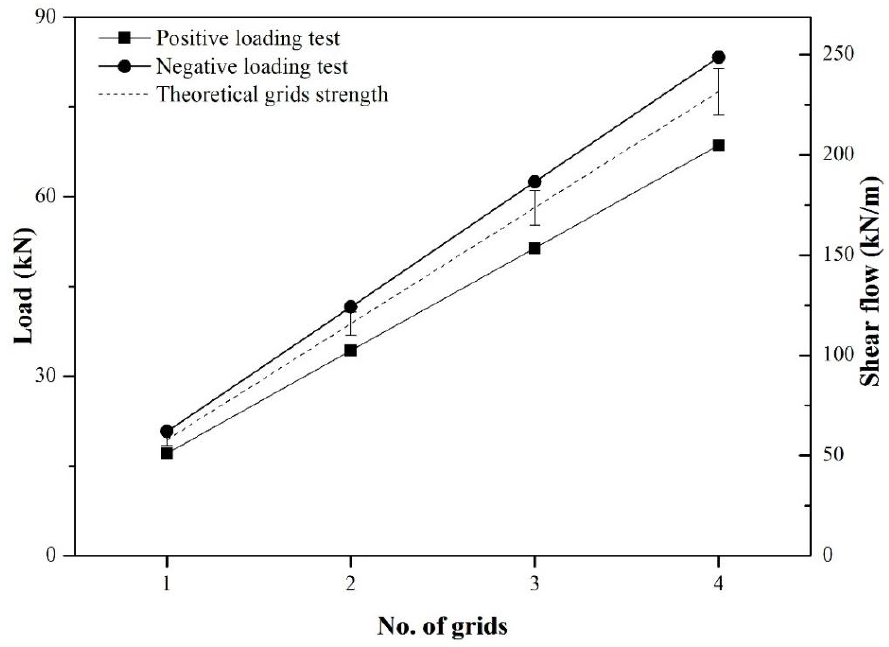
Figure 12. Experimental and theoretical effective shear flow